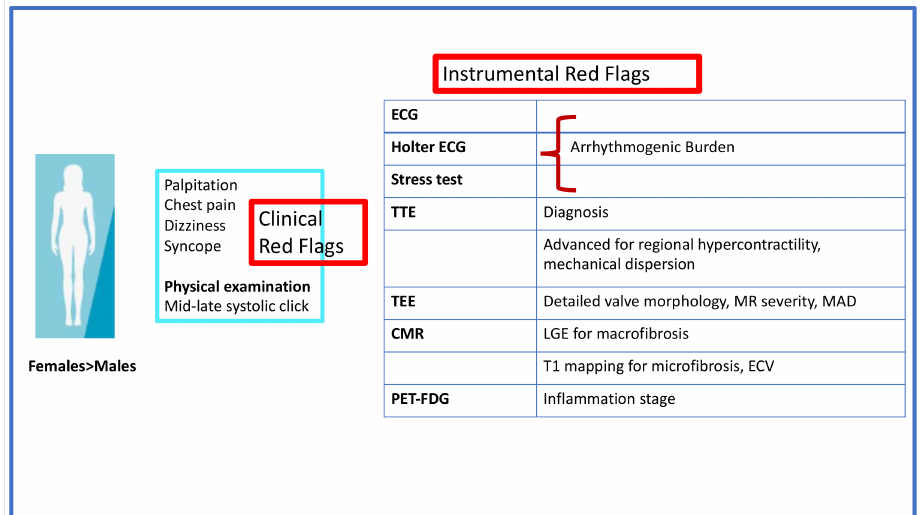
Figure 1. Clinical and instrumental red flags. CMR, cardiac magnetic resonance; ECG, electrocardiog- raphy; ECV, extracellular volume; FDG, fluorodeoxyglucose; LGE, late gadolinium enhancement; MAD, mitral annular disjunction; MR, mitral regurgitation; PET, positron emission tomography; TEE, transesophageal echocardiography; TTE, transthoracic